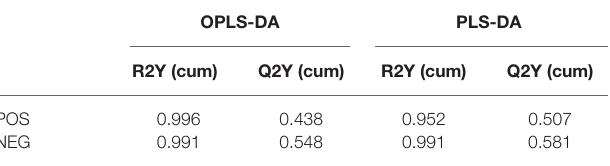
TABLE 1 | Model parameters of multivariate statistical analysis on POS and